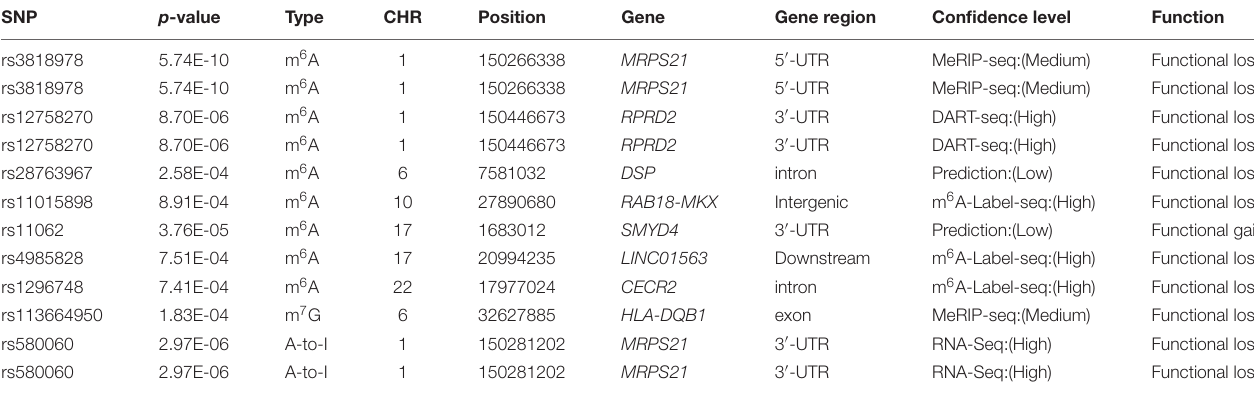
TABLE 2 | Top RNAm-SNPs associated with SCAD.